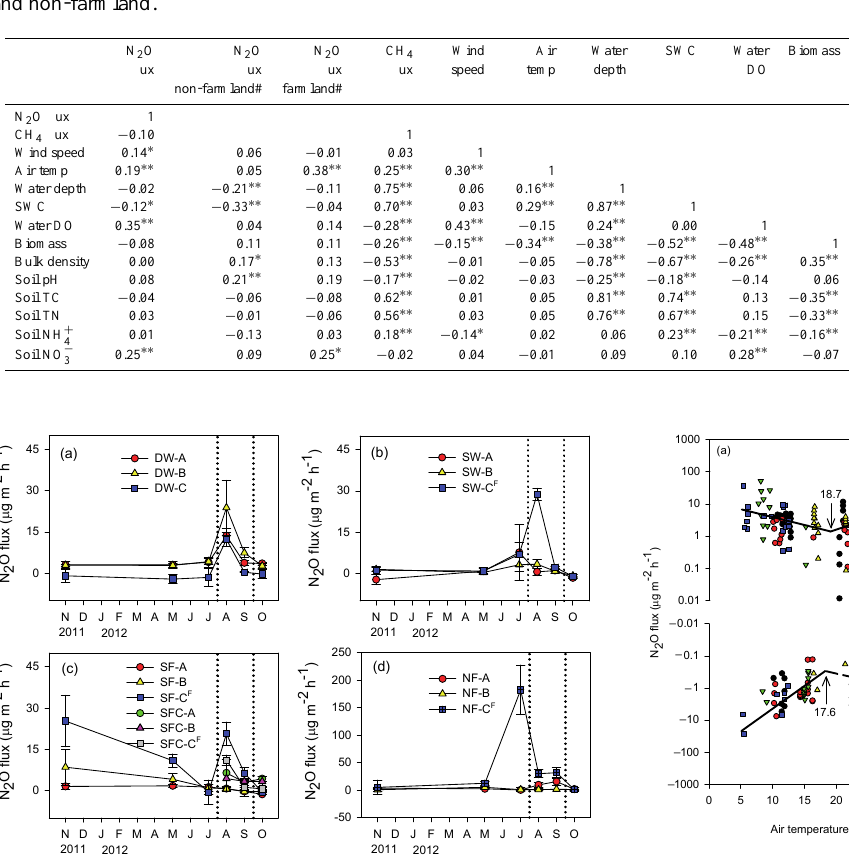
Table 3. Spearman’s rank correlation ( r ) between flux and environmental variables, included in the table are data from M. Yang et al. (2014) on the flux of CH 4 , collected at the same time as the N 2 O. ∗∗ indicates significant correlation ( p < 0.01); ∗ indicates significant correlation ( p < 0.05). SWC: soil water content, DO: dissolved oxygen, TC: total carbon, TN: total nitrogen. Daily average fluxes were used in the correlation analysis; n is from 84 to 324. #: data of DW were not included in the analysis since there was no contract sampling of farmland and non-farmland.